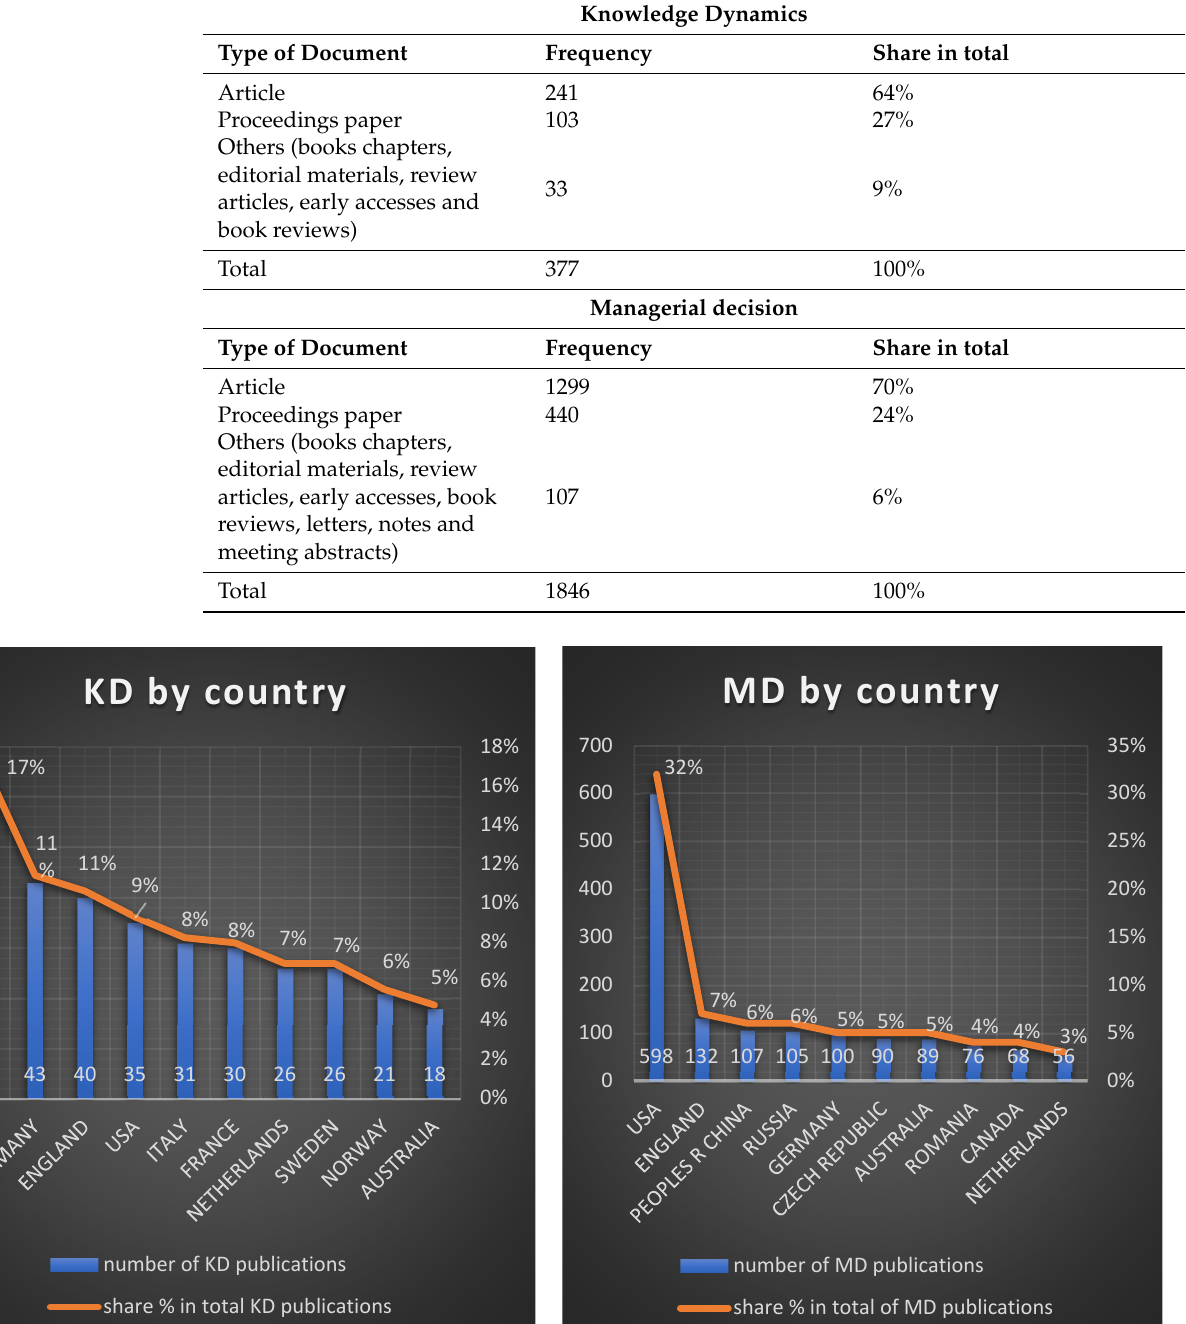
Table 2. Types of retrieved documents for KD and managerial decision on WoS (Source: authors’ own research).